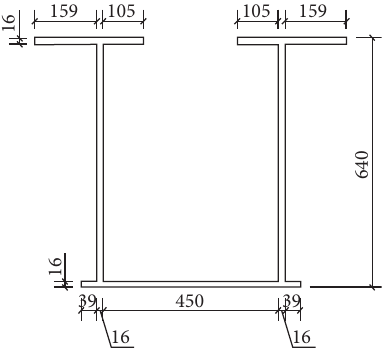
Figure 6: Section diagram of the tied beam (unit: mm).